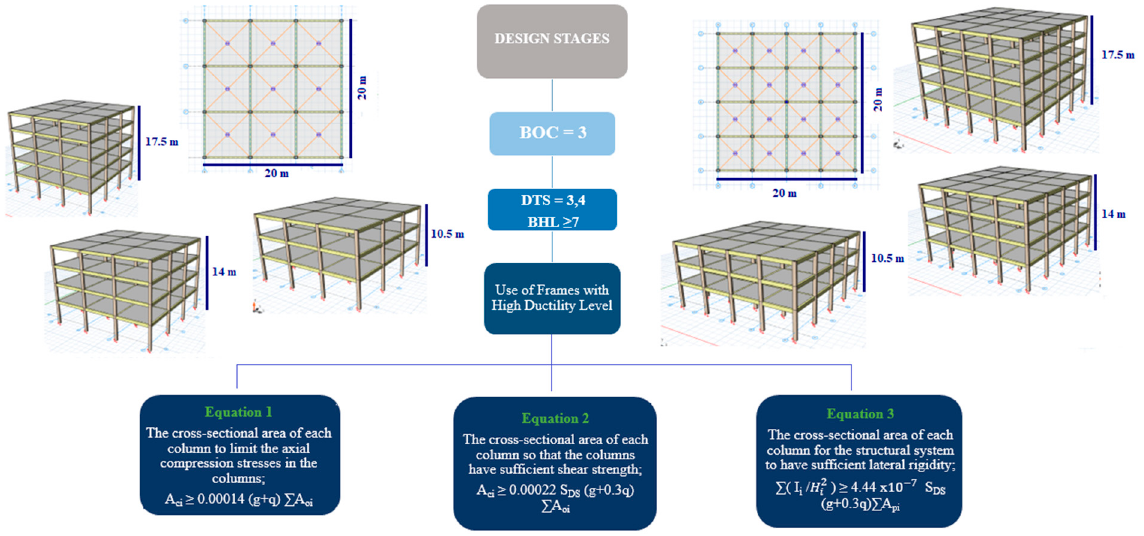
Table 2. Parameters used in building models design.